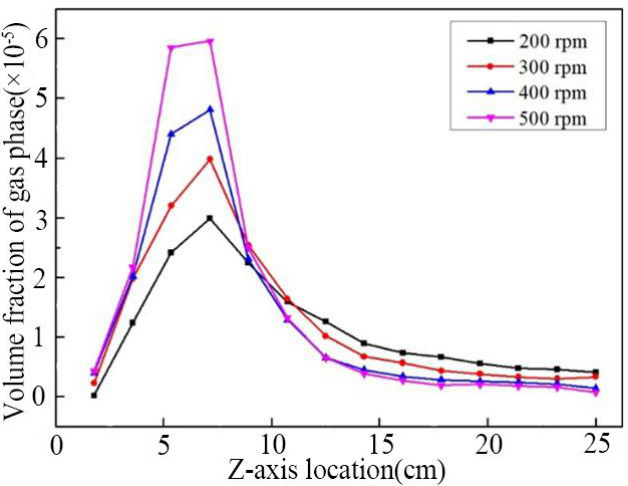
Figure 10. Axial distribution of gas phase volume fraction.